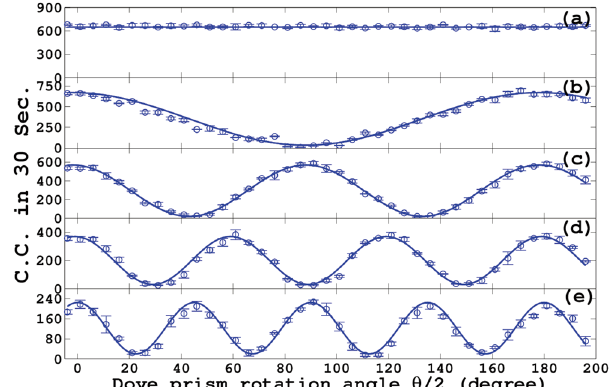
Figure 3. Experimental results for NOON-like states. ( a ) The experimental result for = l 0 . Under the same conditions as in ( a ), the results for =